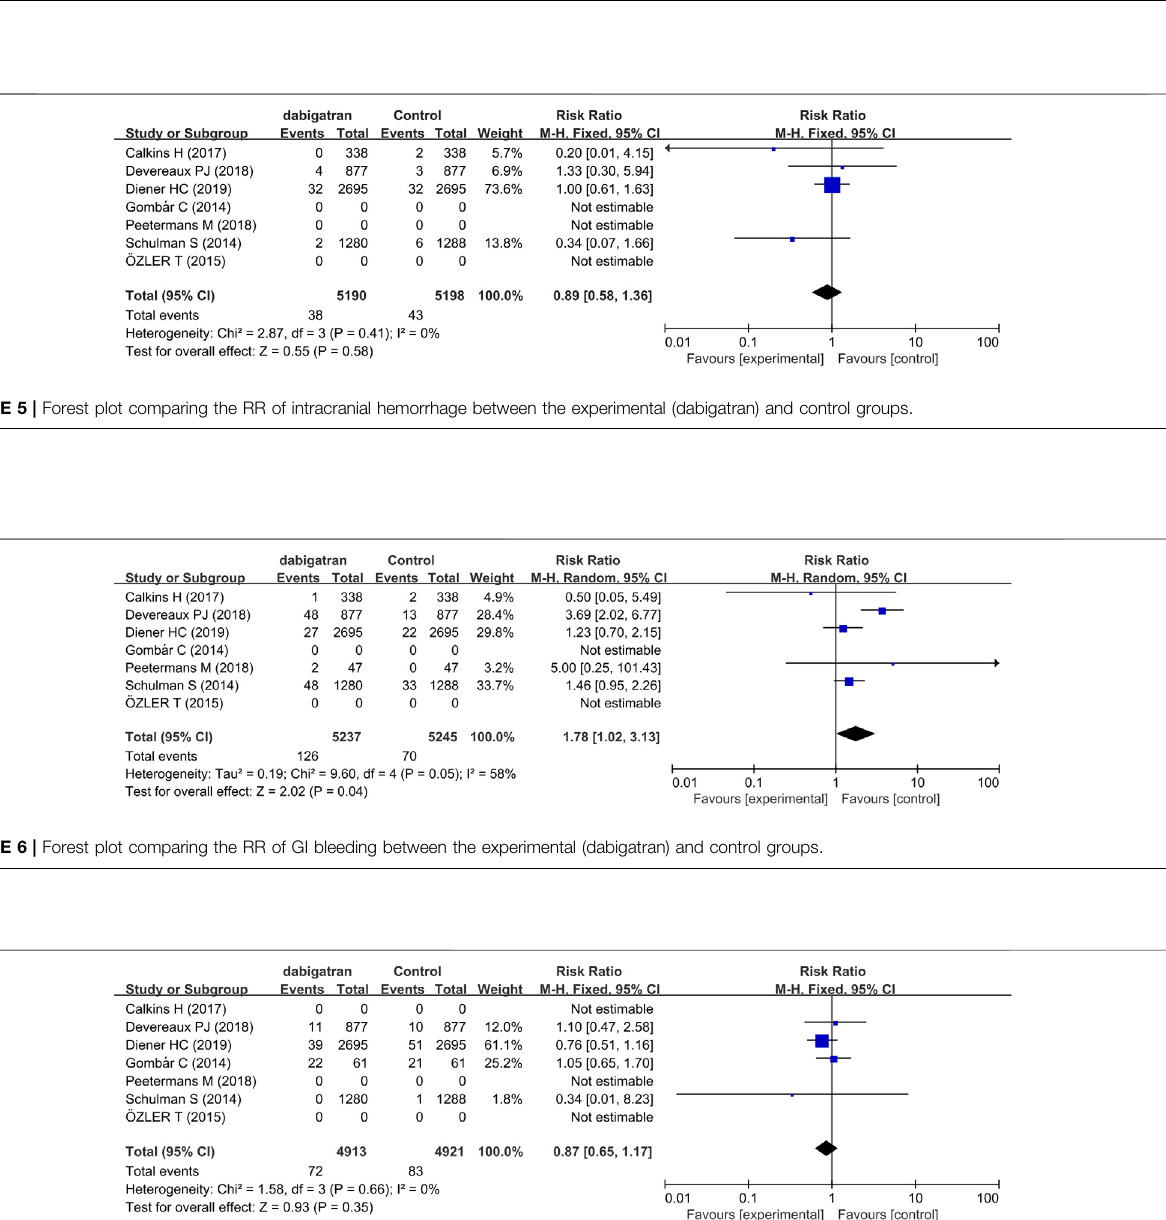
FIGURE 4 | Forest plot comparing the RR of clinically relevant non-major bleeding between the experimental (dabigatran) and control groups.